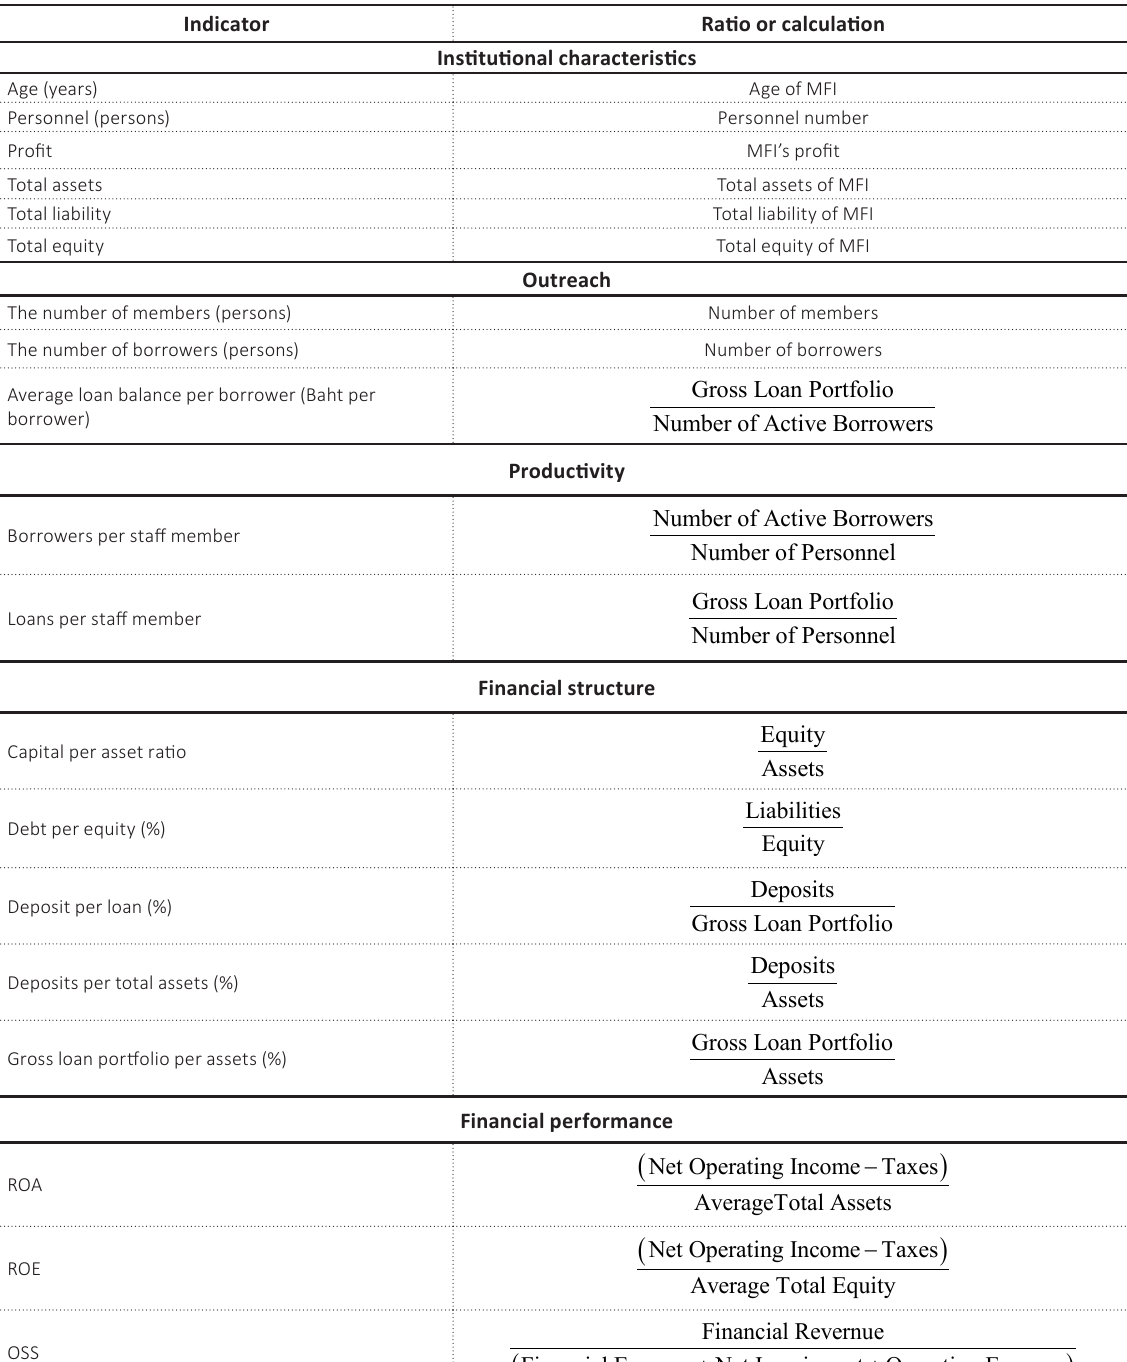
Table 1. Institutional characteristics, outreach, productivity, and financial performance measurement indicators and